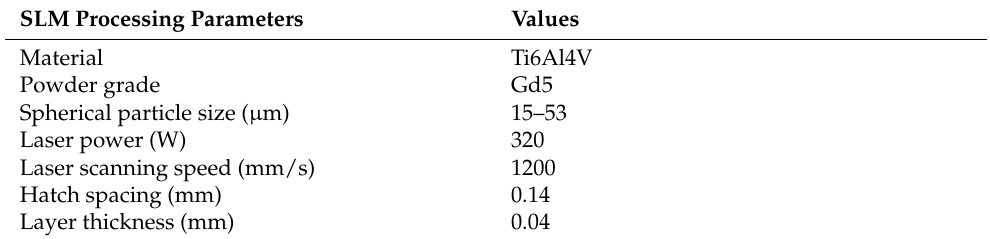
Table 2. Material and processing parameters of SLM.